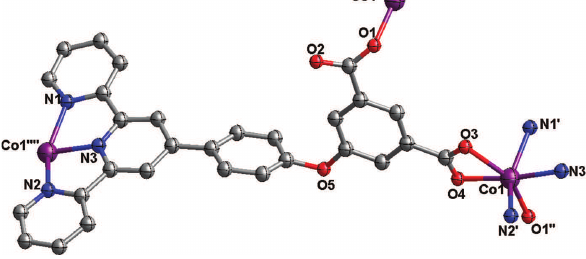
Table 1: Data collection and handling.